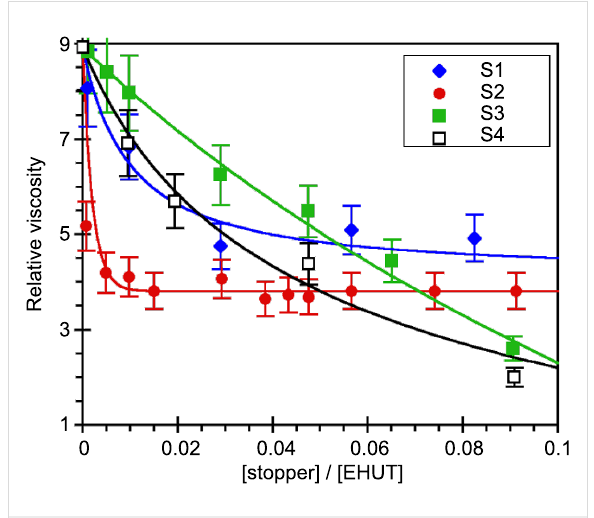
Figure 6: Relative viscosity for solutions of EHUT (1.1 mM) in toluene at 25 °C, with increasing molar fraction of chain stoppers. The lines are a guide for the eye